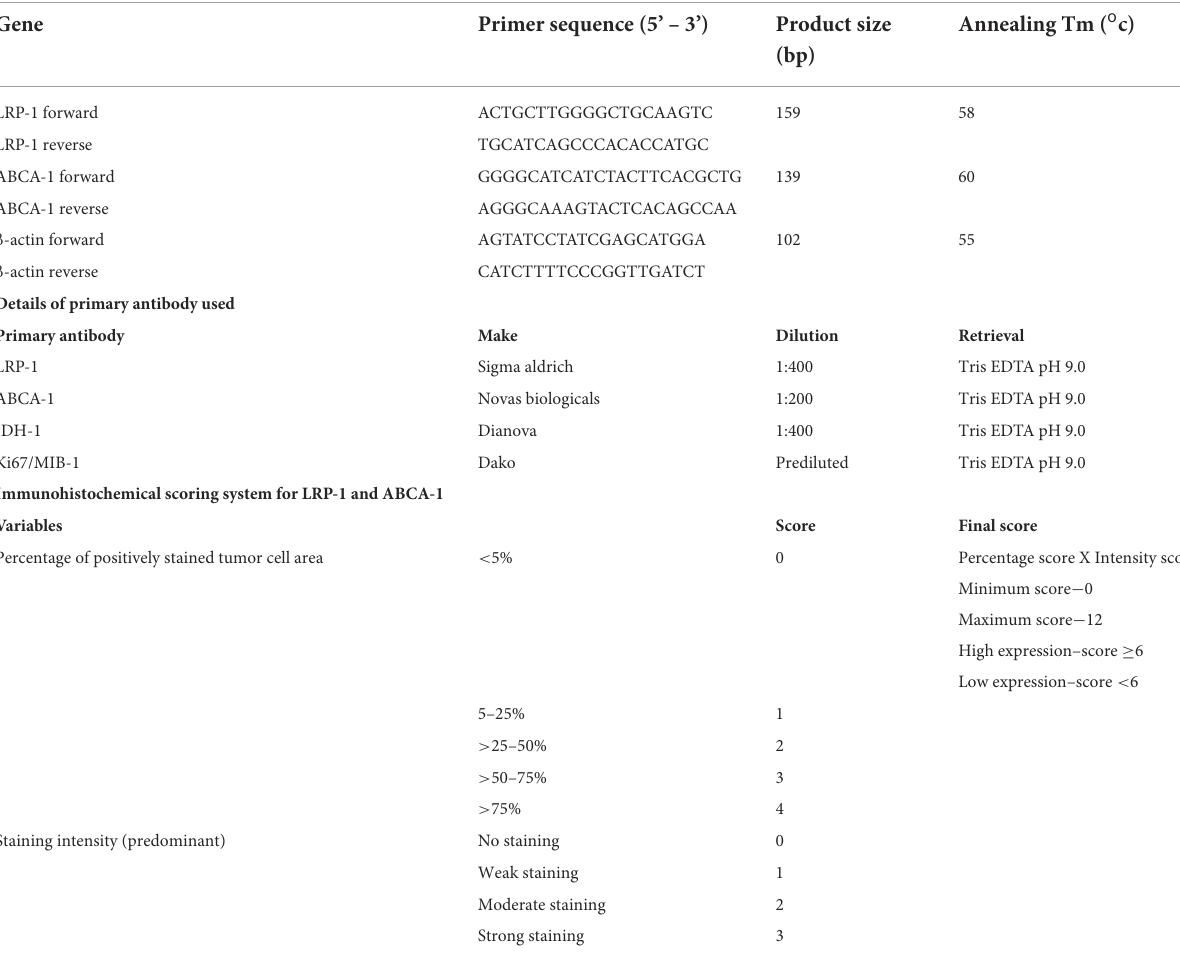
TABLE 1 Details of the primers and primary antibody used in the